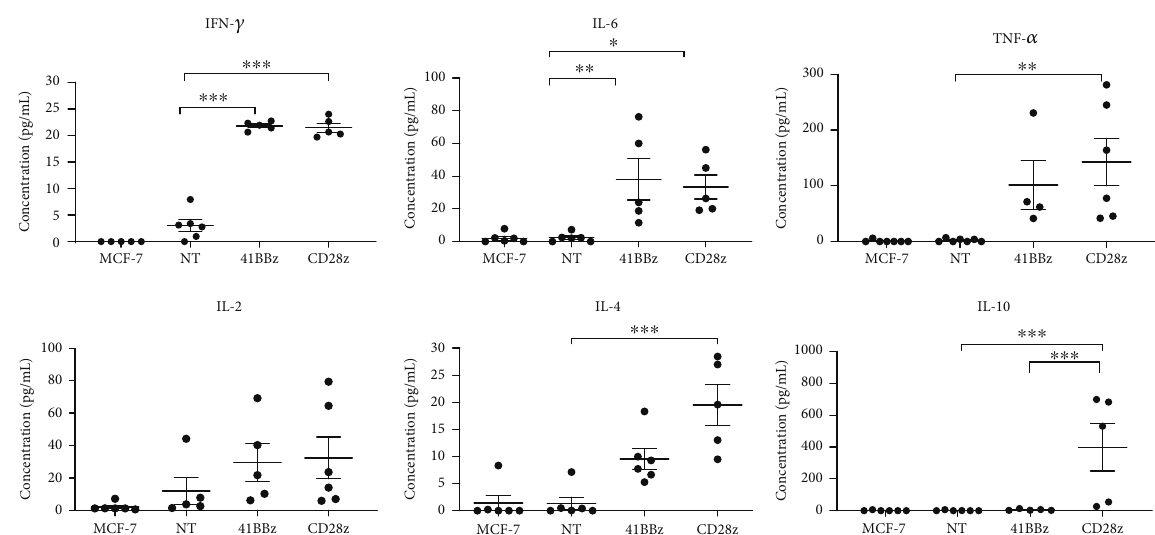
Figure 6: CD28 is associated with upregulation of suppressive cytokines. CAR.MUC1-41BB ζ and CAR.MUC1-CD28 ζ were cocultured with MUC1 + breast cancer cell line at e ff ector: target (E:T) ratio 1: 1 without adding cytokine. Culture supernatants were collected and analyzed for cytokine concentration (IFN- γ , TNF- α , IL-10, IL-6, IL-4, and IL-2). Data represent as mean ± S : E : M ( n = 6 ). Data were analyzed by one- way ANOVA. P value signi fi cance is indicated as ∗ for P < 0 : 05 , ∗∗ for P < 0 : 01 , and ∗∗∗ for P < 0 : 001